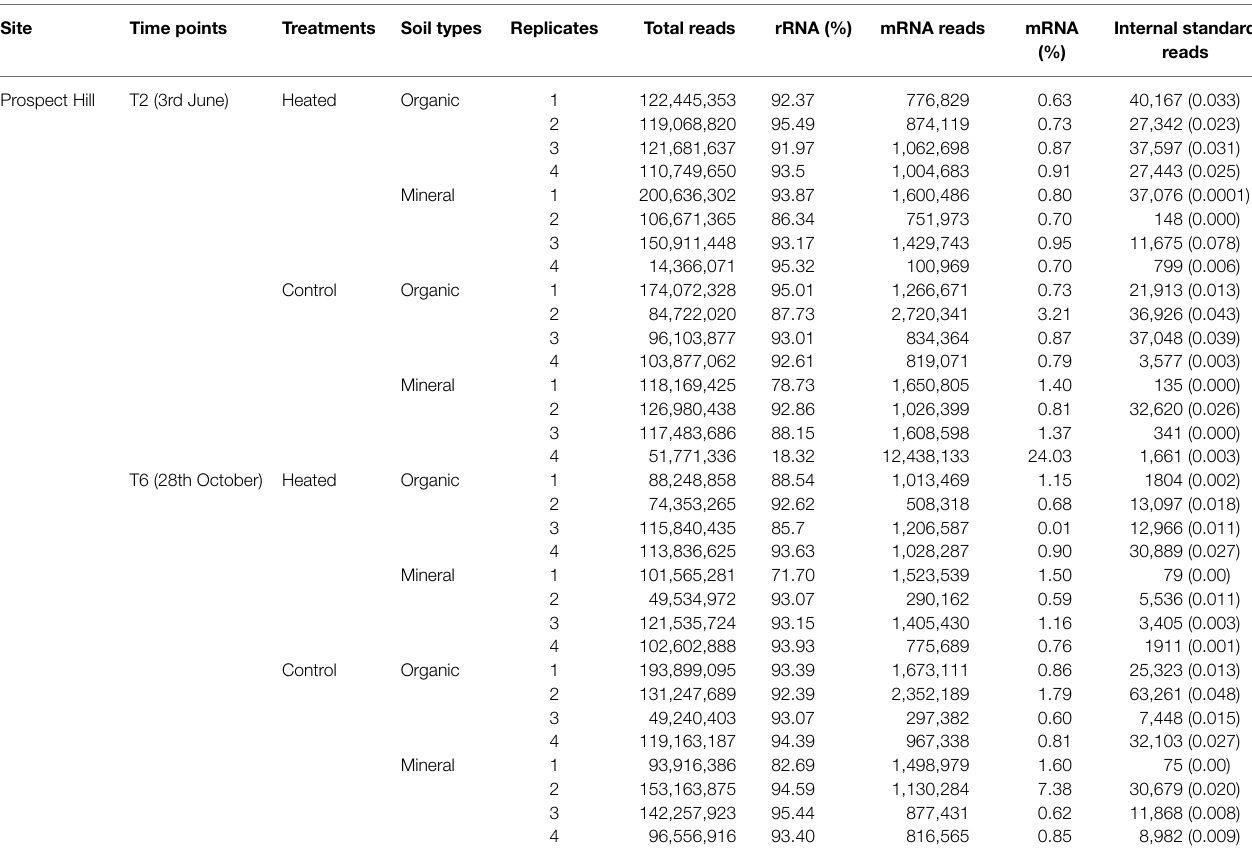
TABLE 1 | Sequencing output – RNA sequencing results with percentages of rRNA, mRNA, and number of internal standard reads recovered from each sample. Site Time points Treatments Soil